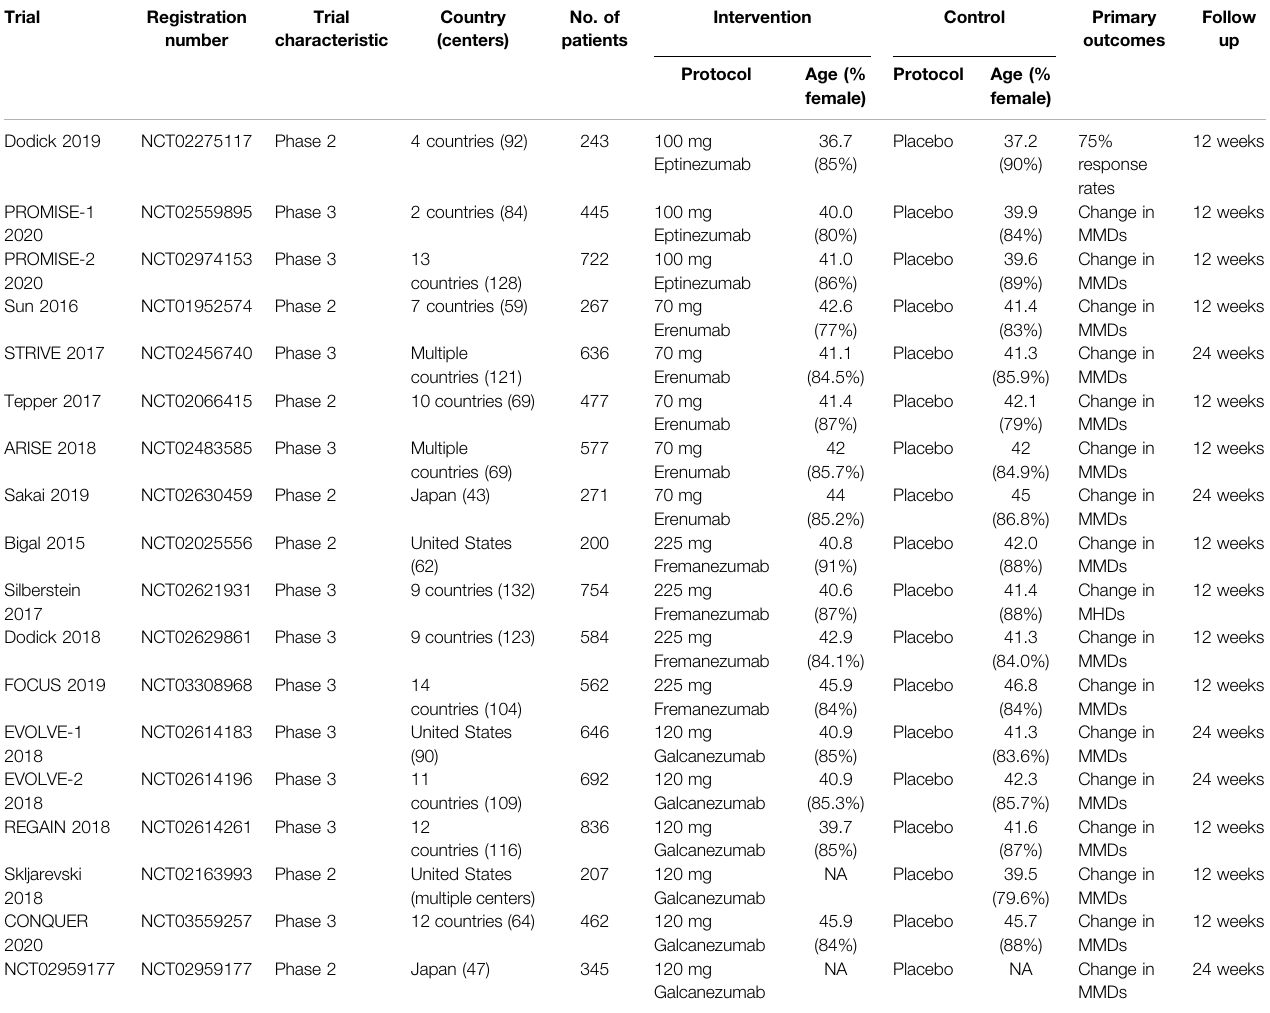
TABLE 1 | Characteristics of trials included in the systematic review and network